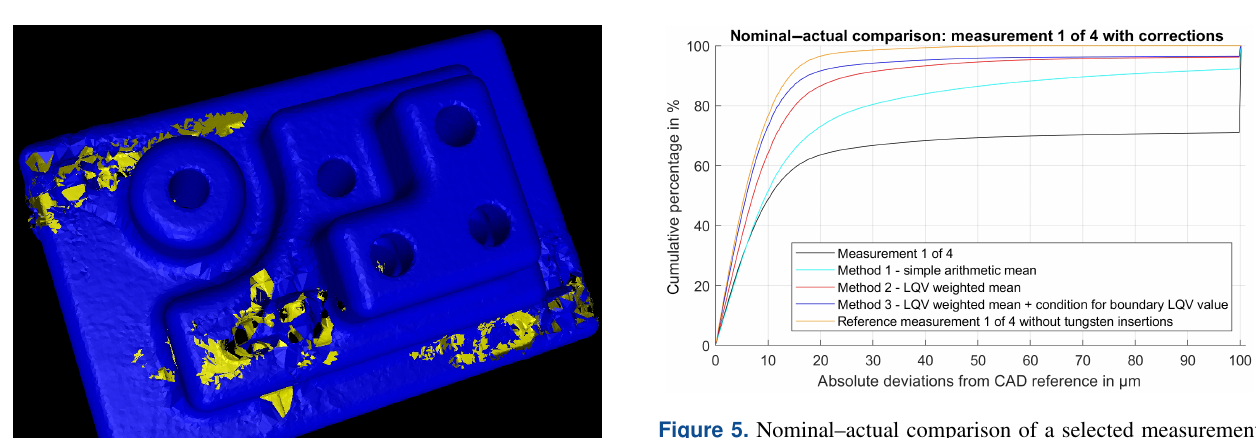
Figure 5. Nominal–actual comparison of a selected measurement (1 of 4, Fig. 3) and its corrections with the CAD reference